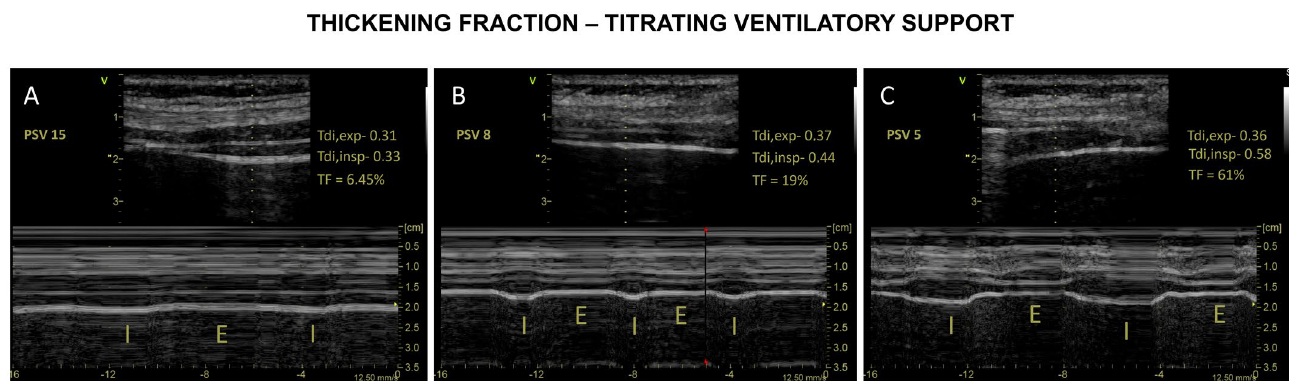
Figure 4. Diaphragm ultrasound to monitor effort. Titrating effort according to thickening fraction (TF). Panel A —Reduced TF suggestive of over-assistance (PSV 15 cm H 2 O). Panel B —“Ideal” TF suggestive of appropriated effort (PSV 8 cm H 2 O). Panel C —Increased TF suggestive of under-assistance (PSV 5 cm H 2 O).